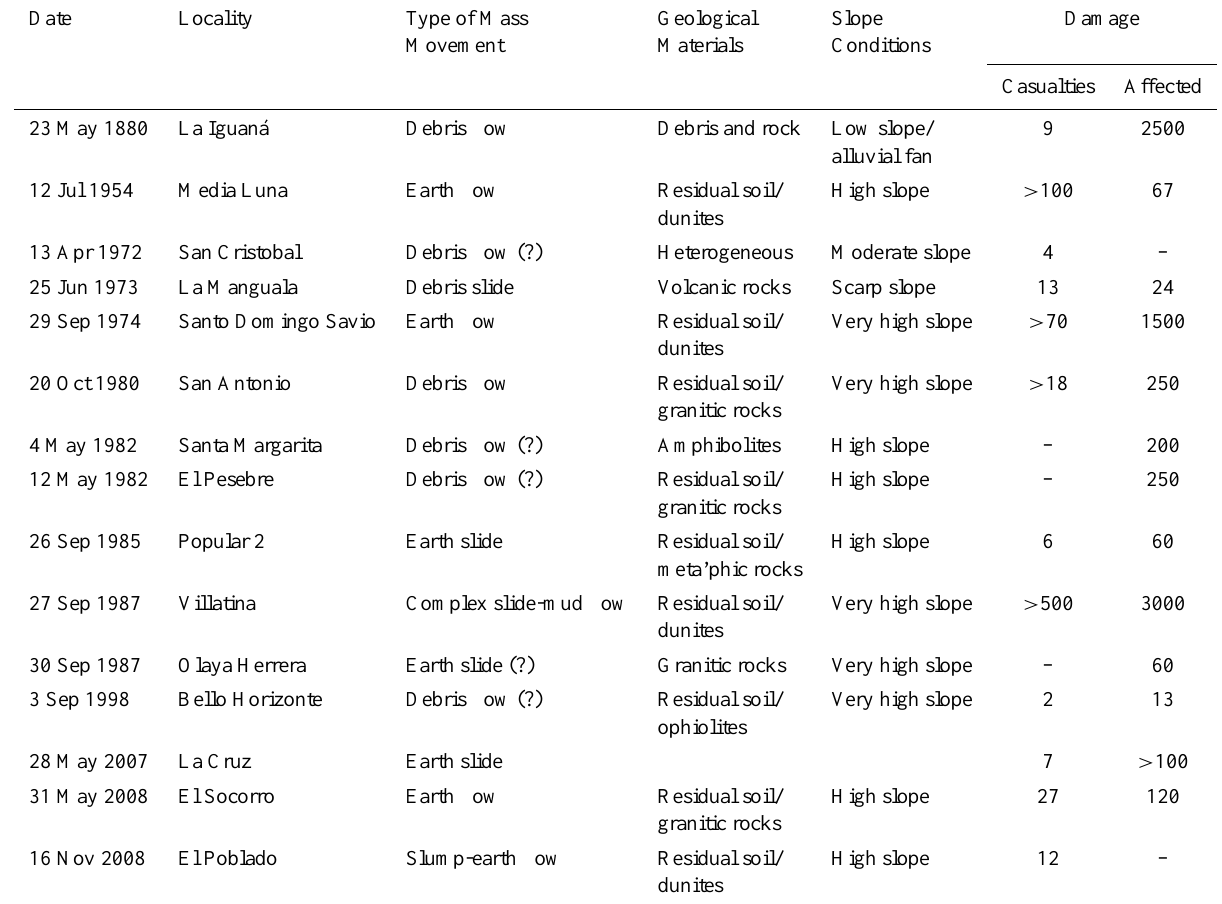
Table 1. Major landslides within the Medell´ın Valley compiled according to ´Area Metropolitana (2007) and the local newspapers EL COLOMBIANO and EL TIEMPO. The highlighted localities indicate those landslides to have occurred within the Iguan´a River Basin. The column “killed” refers to the number of persons confirmed as dead and/or persons missing and presumed dead. The column “affected” refers to the number of people requiring immediate assistance during the emergency period, i.e. displaced or evacuated people. Where a question mark occurs next to the type of mass movement, the process is